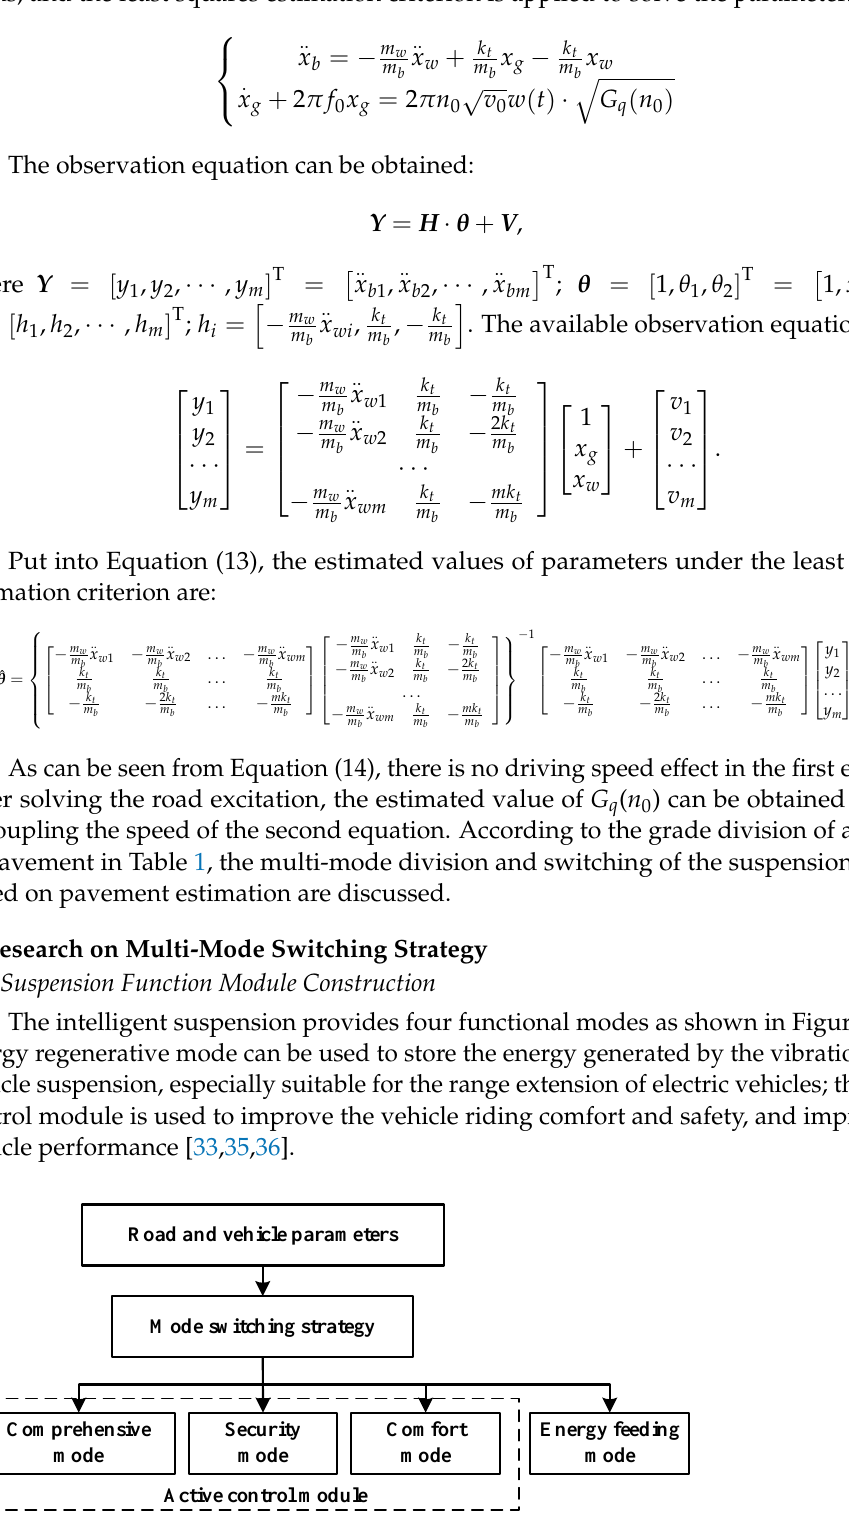
Figure 5. Multi-mode switching control